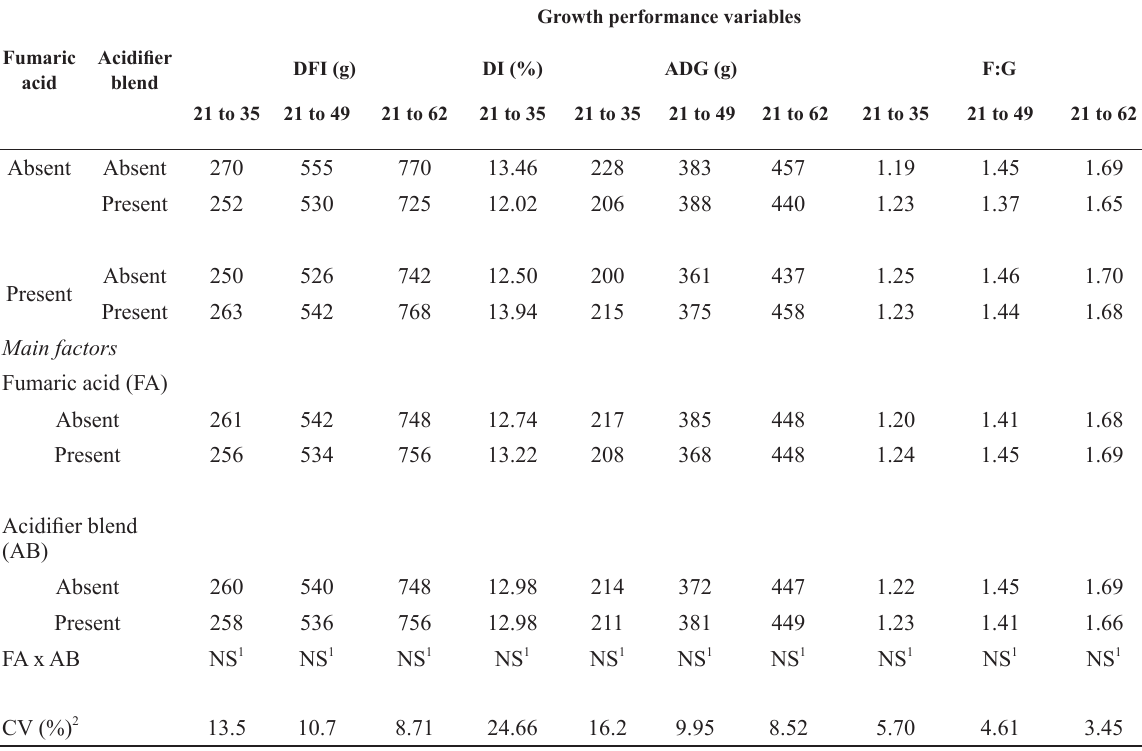
Means of performance variables at periods 21 to 35, 21 to 49, and 21 to 62 of piglets’ age. Growth performance